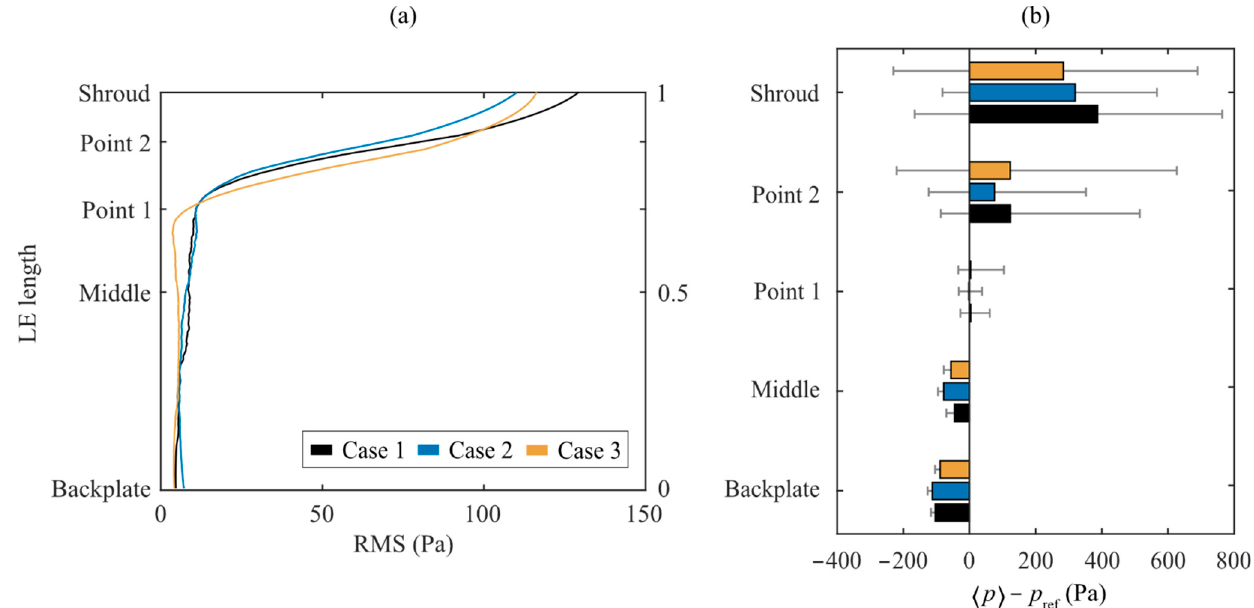
Figure 7. Pressure at BLE. ( a ) The RMS of the pressure fluctuations for 12 fan revolutions, on one blade at the monitoring line; ( b ) the time-average pressure and error bars showing the minimum and maximum pressure.